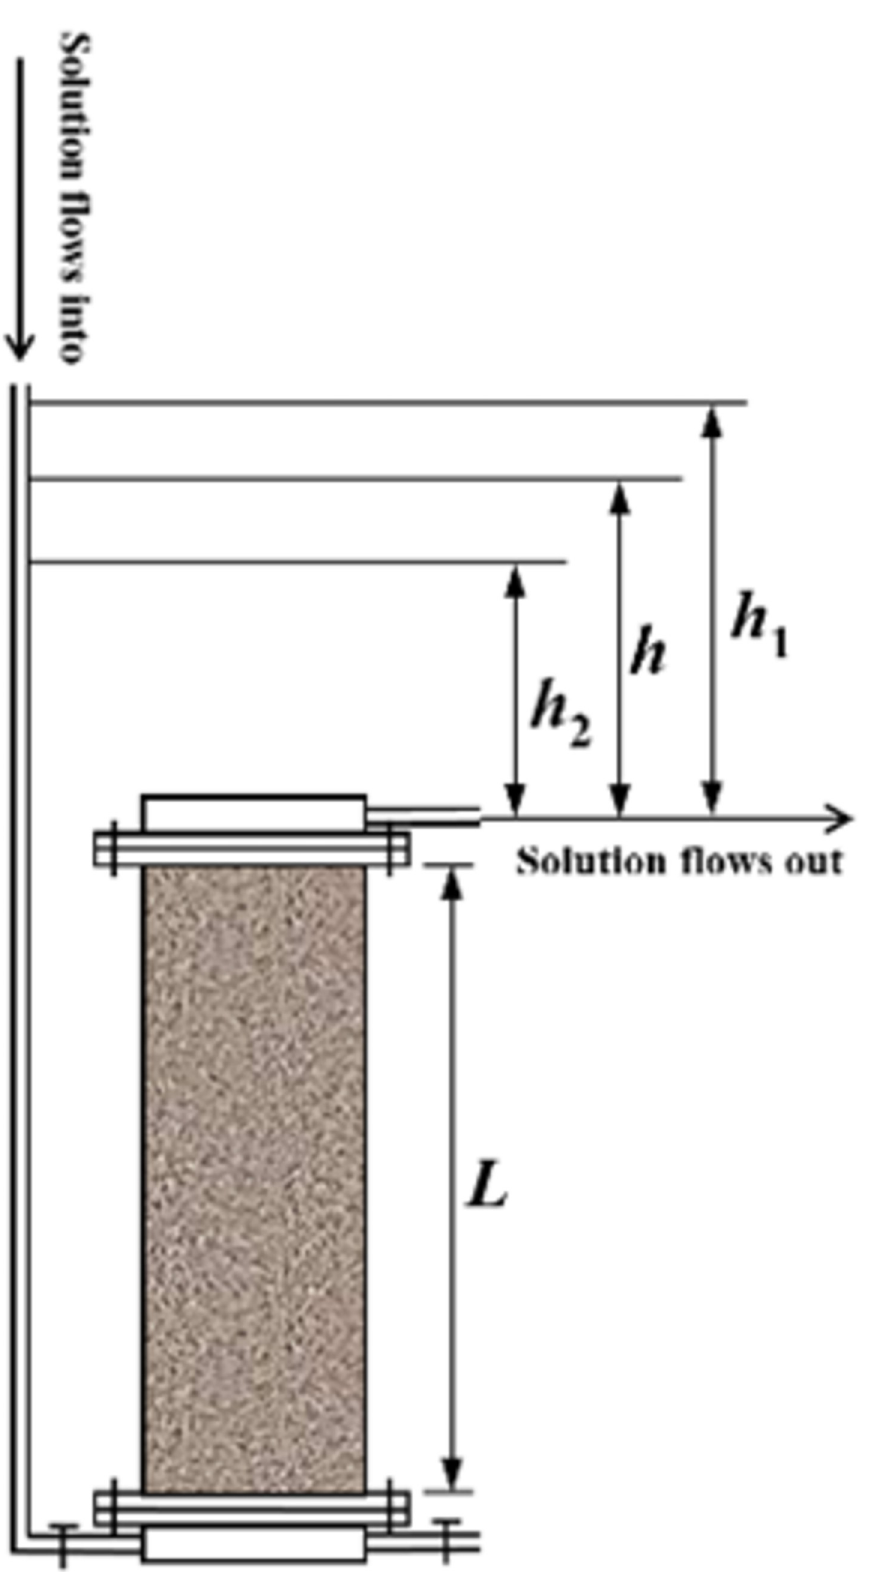
Fig 3. Details of the test